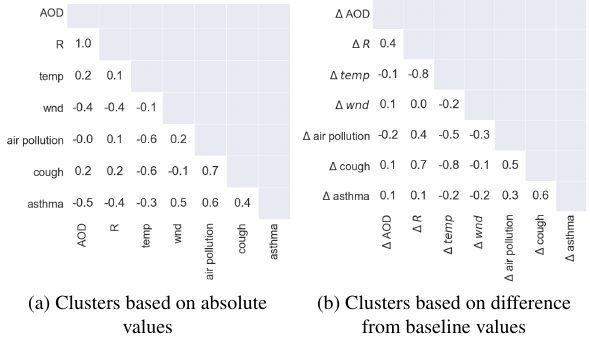
Figure 2. Difference of R from 2015 and 2001 highlighting the study locations and annual percentage cloud-free observable Figure 3. Heat map showing correlation between mean values of days using MODIS. the clusters based on the (a) absolute values and (b) and difference from mean( ∆ ) for concentration R , temperature temp and wind speed wnd